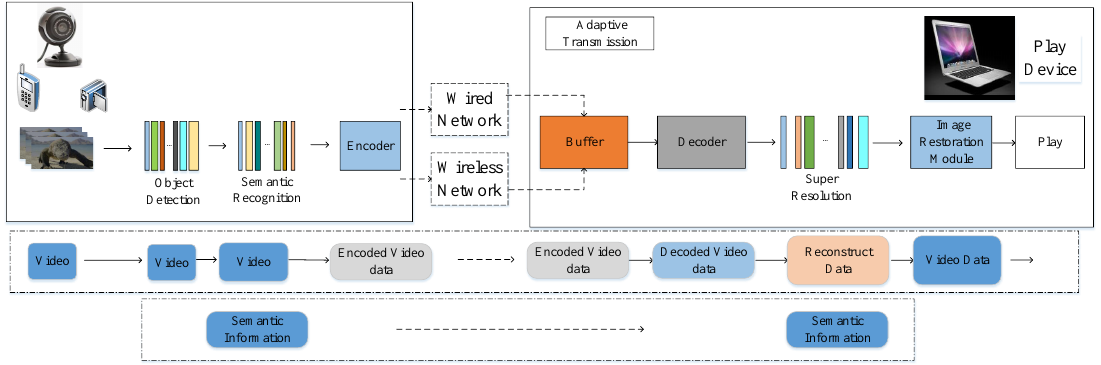
Figure 2. The proposed SASRT architecture for adaptive transmission over